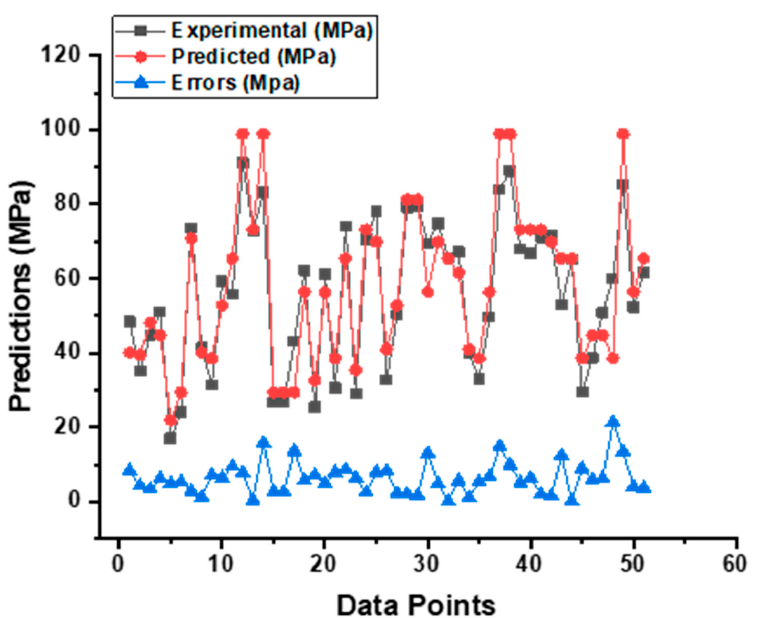
Figure 8. Indication of the error’s difference between the actual and forecasted CS result of SCC from ML model.